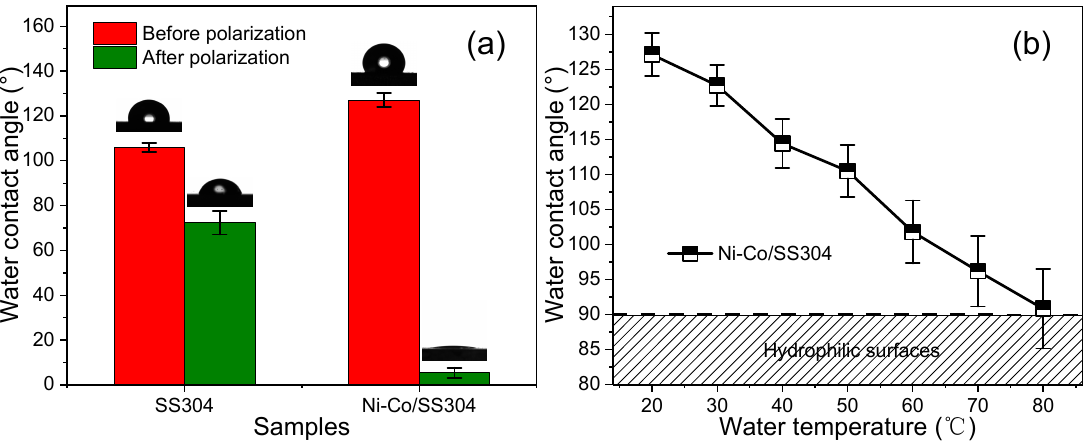
Figure 10. ( a ) WCAs of bare SS304 and Ni–Co/SS304 surfaces before and after polarization (0.6 V, 5 h); ( b ) WCAs of Ni–Co/SS304 surface under water droplets at different temperatures.